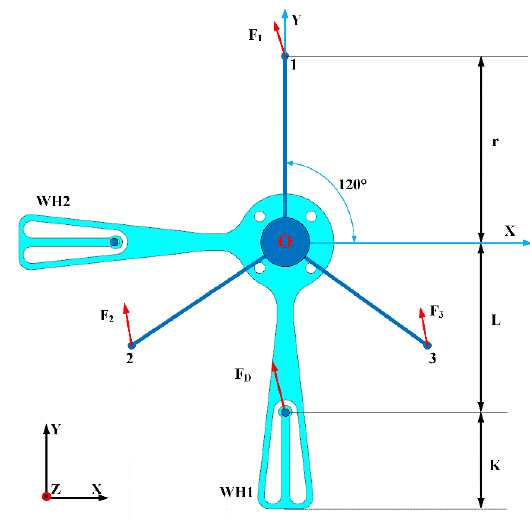
Figure 2. Schematic diagram of WH